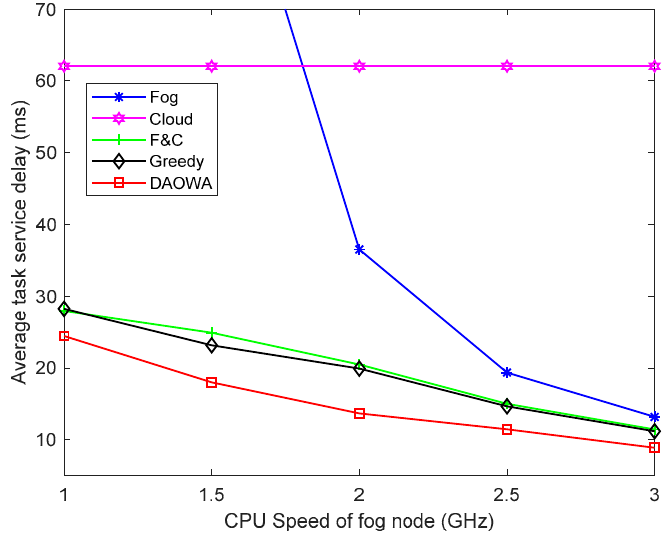
Figure 7. Average task service delay vs. fog node computing Figure 7 . Average task service delay vs. fog node computing speed.